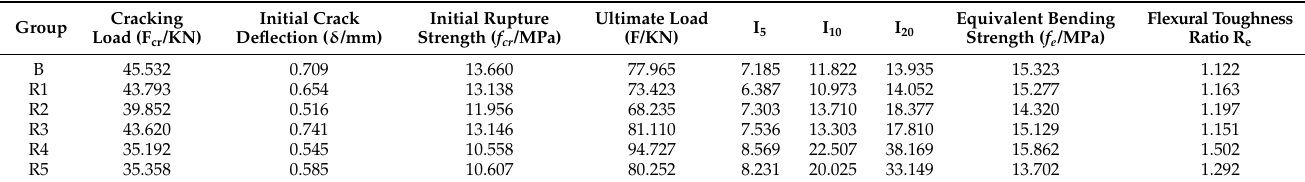
Table 7. Calculation results of bending toughness